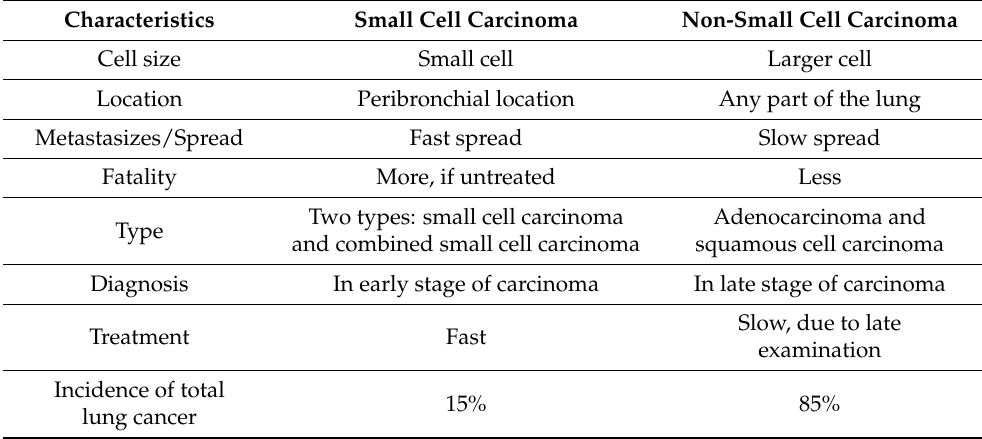
Table 1. Comparison between small cell lung carcinoma and nonsmall cell lung carcinoma.